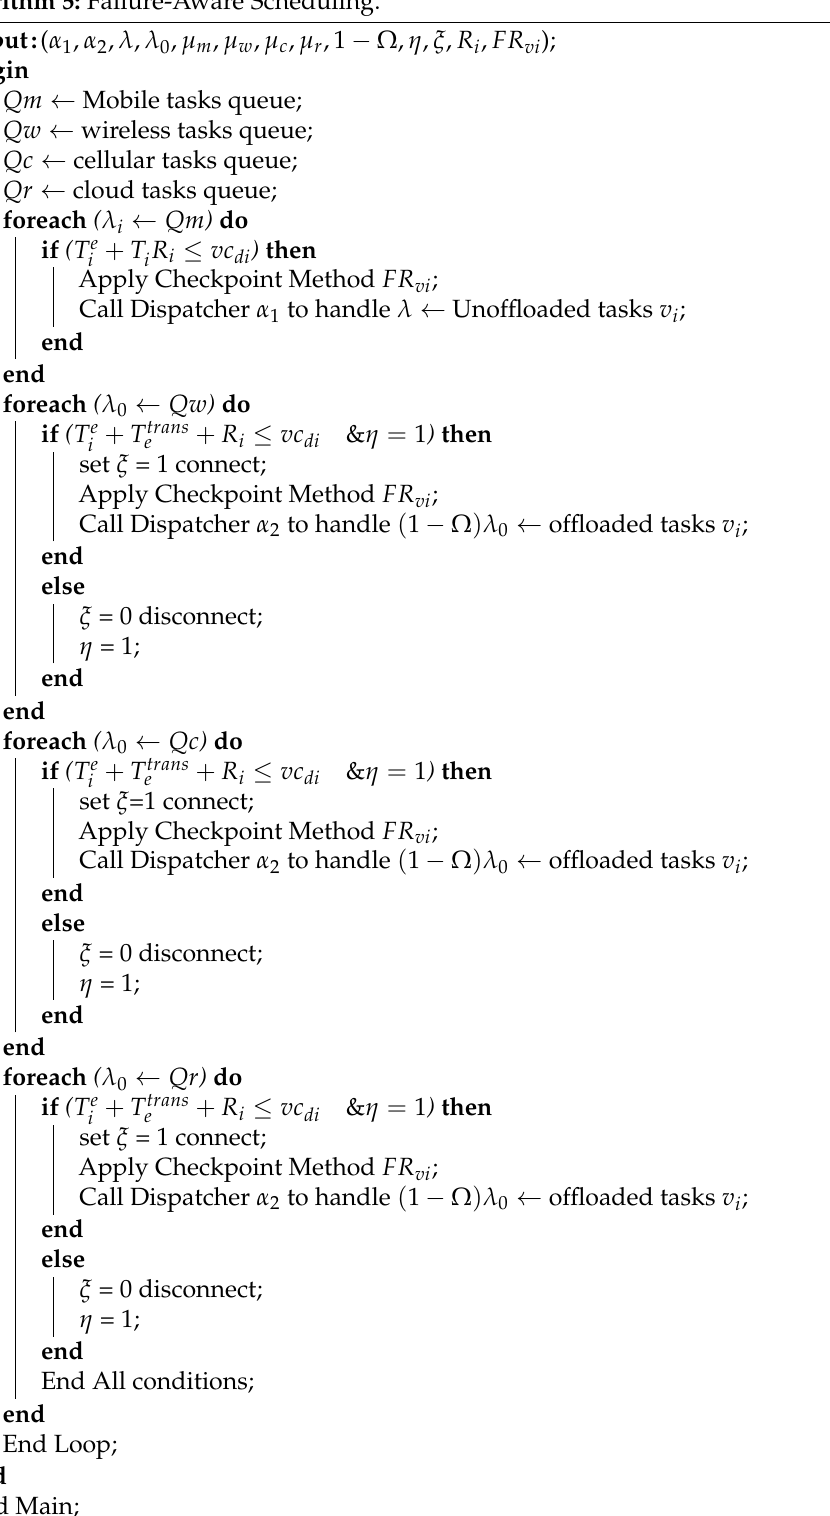
Algorithm 5: Failure-Aware